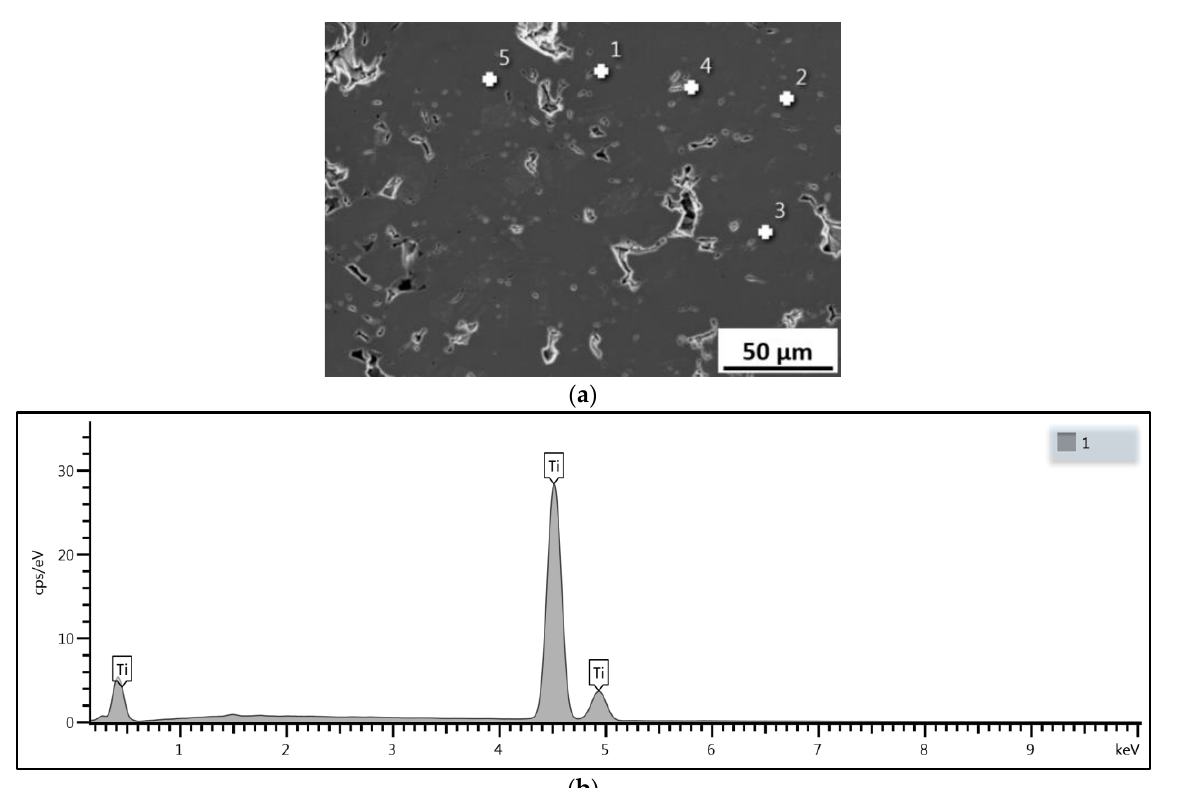
Figure 9. X-ray diffraction patterns of the titanium powder and cold-sprayed titanium coatings deposited at different standoff distances (20–100 mm).